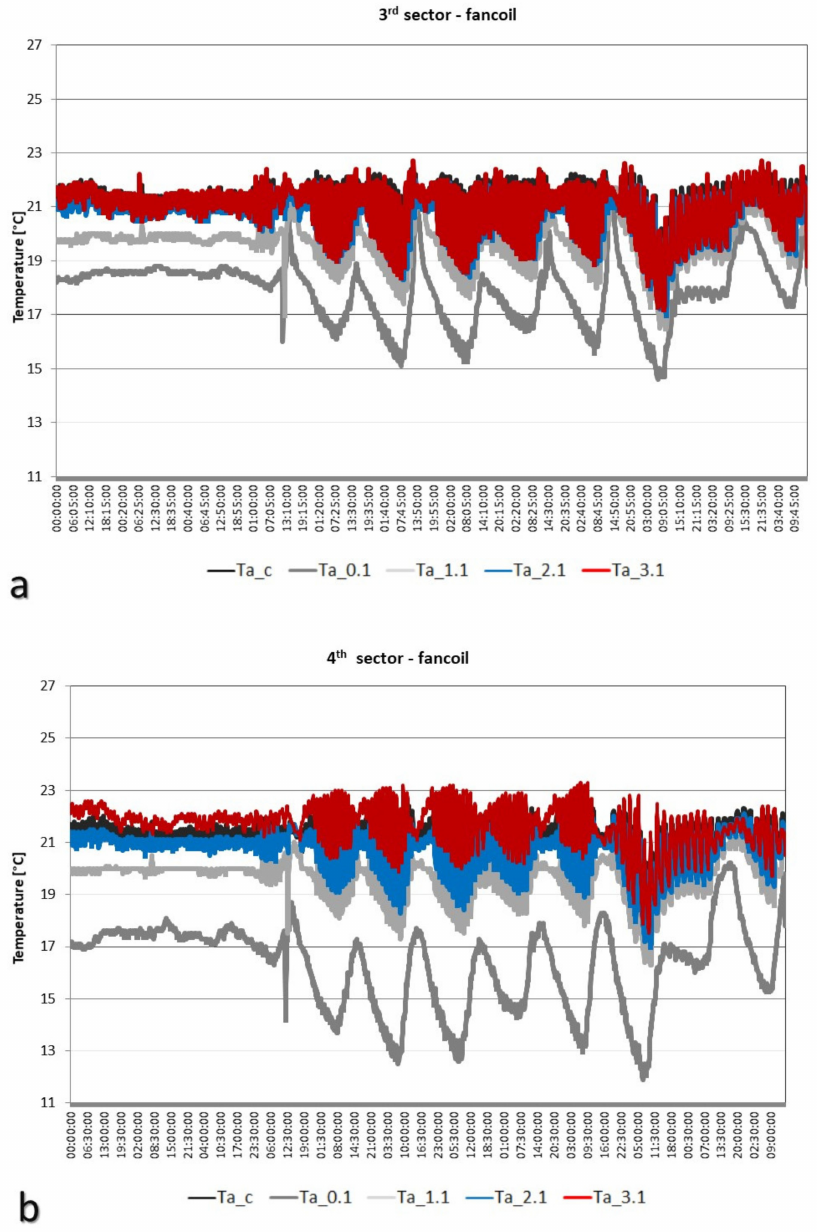
Figure 10. Air temperature at different heights with fan coil units: ( a ) 3rd sector, ( b ) 4th sector. Comparing the four sectors, it is evident that S2 was characterized by the highest values. The temperature profiles relating to the same height but on different sectors were quite comparable; there was not evident horizontal asymmetry, especially at a height of 1.1 m and 2.1 m. Instead, considering the position at 3.1 m, the difference between air temperatures recorded at the same time in S1 and S2 varied between − 4.0 ◦ C and +2.0 ◦ C, and it varied from –2.6 ◦ C and 3.7 ◦ C considering sectors S2 and S4. At the height